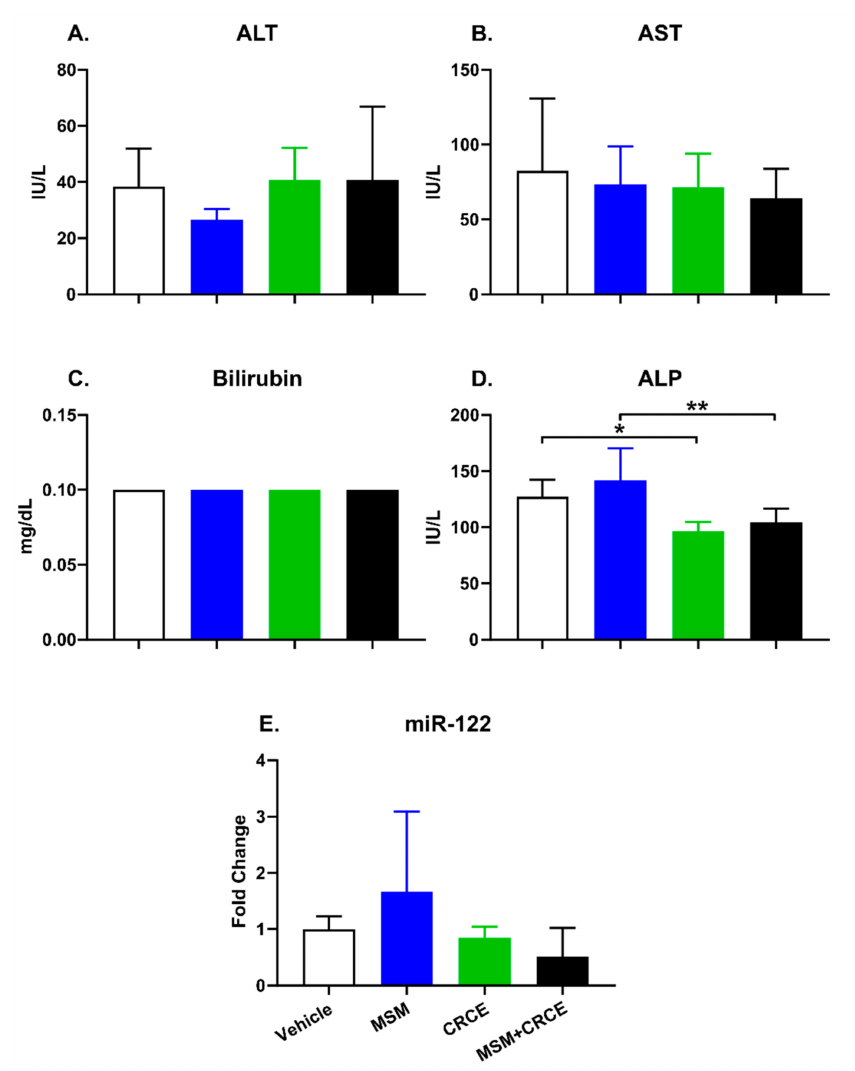
Figure 3. E ff ects of MSM, CRCE, or MSM / CRCE on plasma biomarkers of liver injury. ( A ) alanine aminotransferase, ALT; ( B ) aspartate aminotransferase, AST; ( C ) total bilirubin; ( D ) alkaline phosphatase (ALP); ( E ) miR-122. Data are presented as mean ± SD ( n = 6–8). * indicates a significant di ff erence ( p < 0.05), and ** indicates a significant di ff erence ( p < 0.01), as calculated with a two-way ANOVA